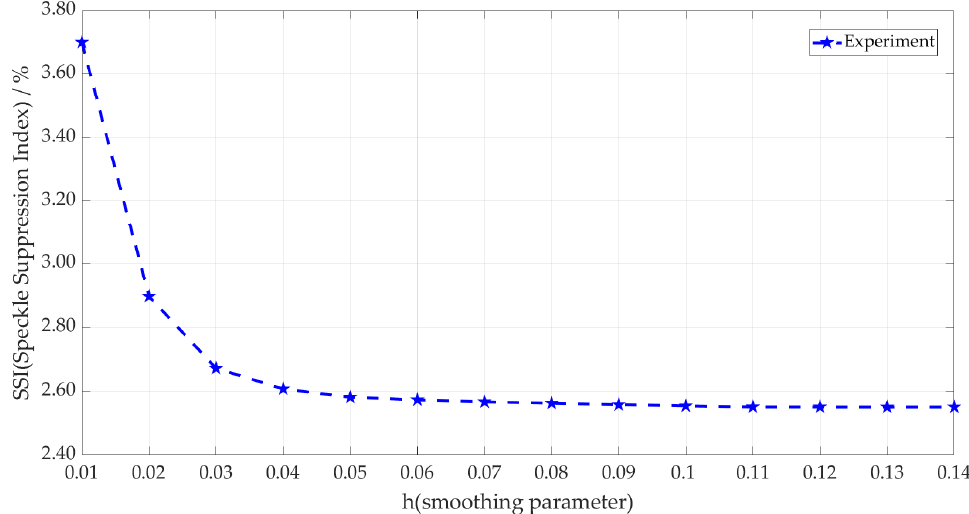
Figure 7. Optimal h-values of I-NLM using adaptive h-solving method.